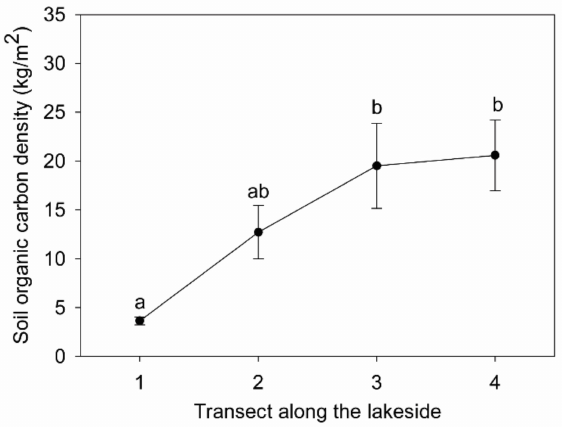
Figure 4. Soil organic carbon density and its variation in four transects (vegetation types) along the lakeside of West Mauri